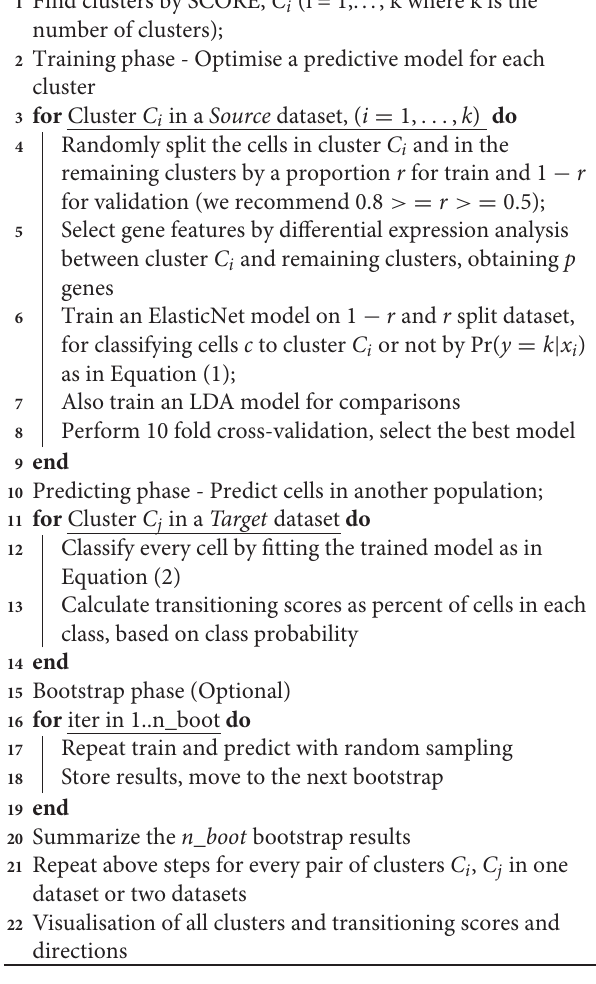
Algorithm 2: scGPS trajectory